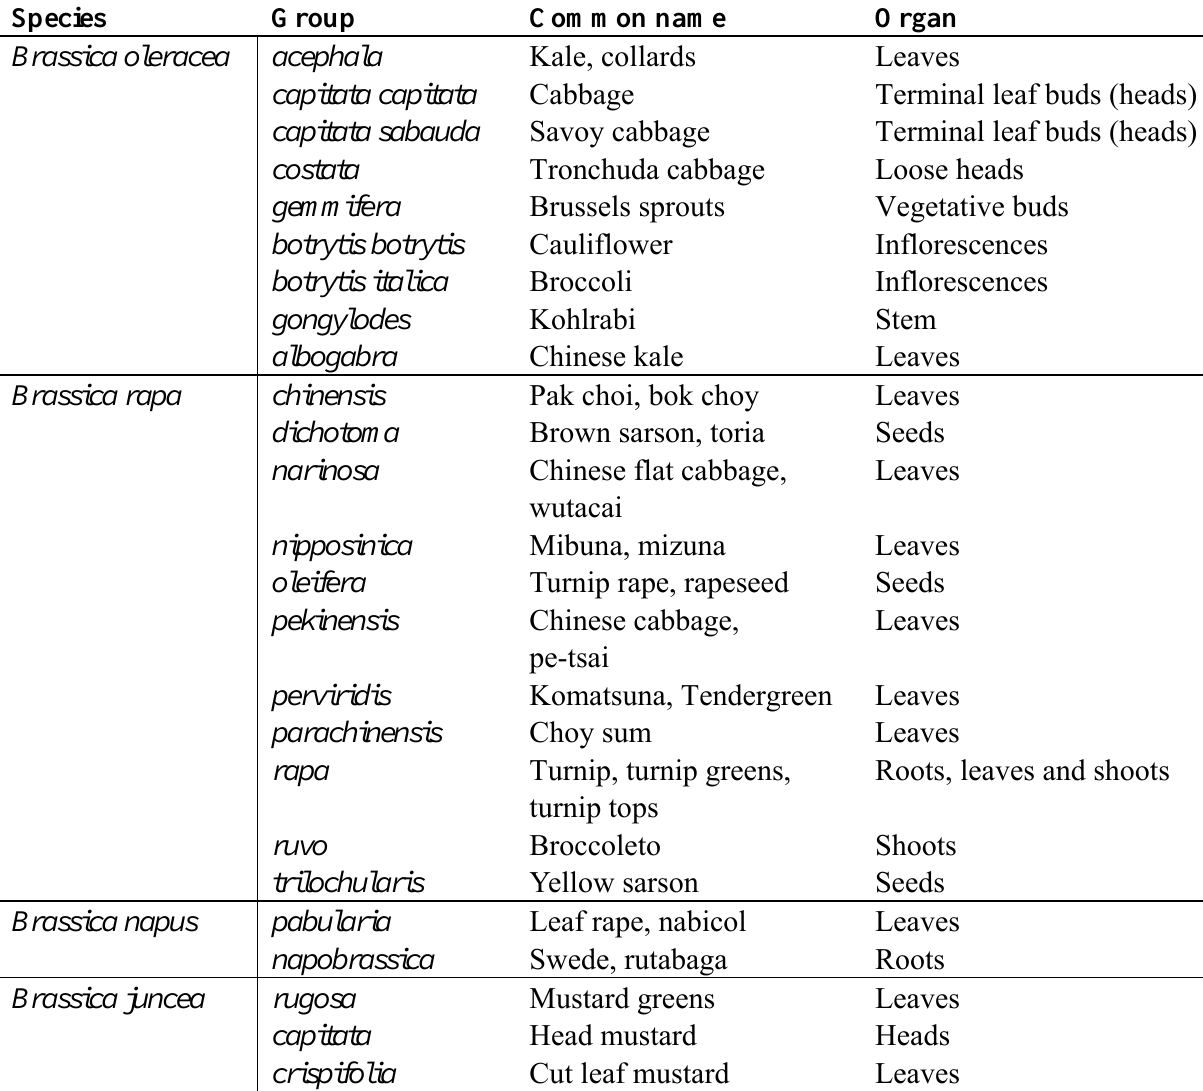
Table 1. Main vegetable Brassica species, crops, and plant parts used for